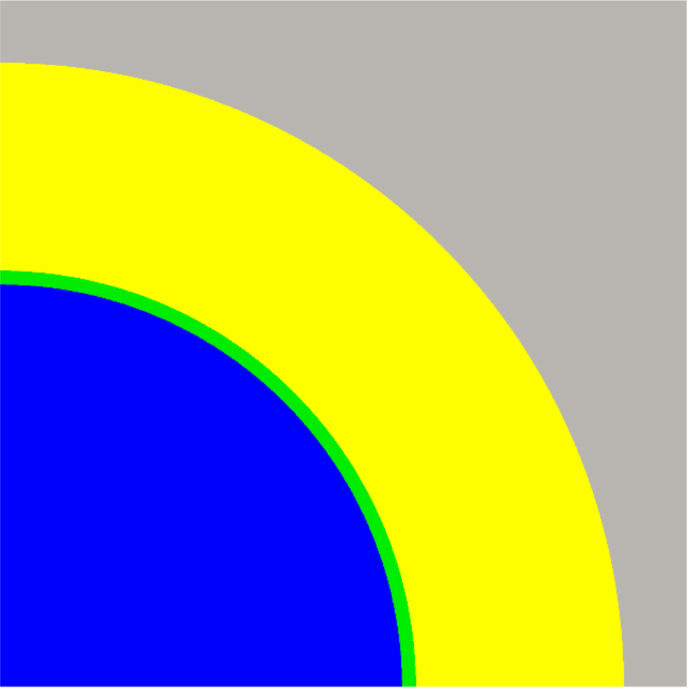
Figure 4. 2D SCALE/TRITON/NEWT model (molten salt fuel core—blue, stainless steel—light green, NaCl reflector—yellow, vacuum—gray) used for the analysis of the neutron flux